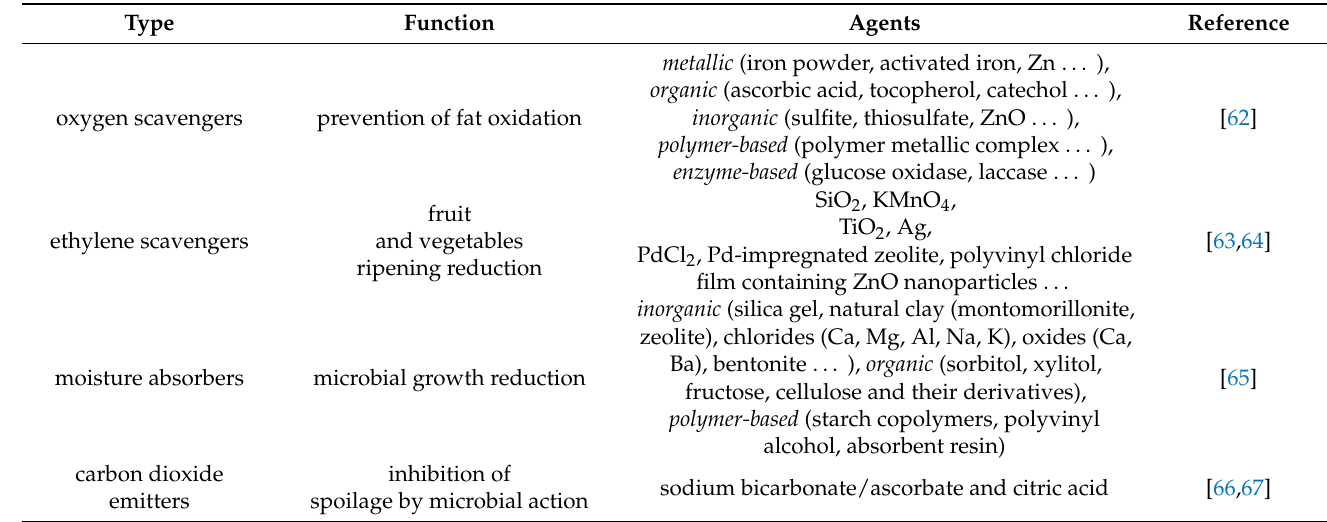
Table 3. Functional properties of active food packaging to extend shelf life and improve food